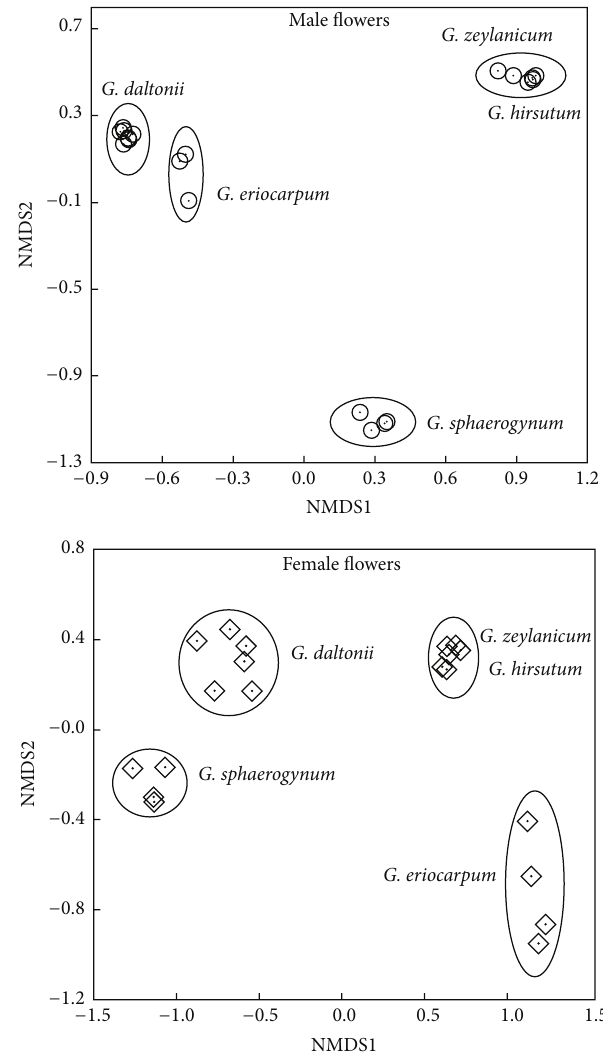
Figure 4: Score plots from nonmetric multidimensional scaling (NMDS)offloralscentsinmaleandfemaleflowersoffive Glochidion species.